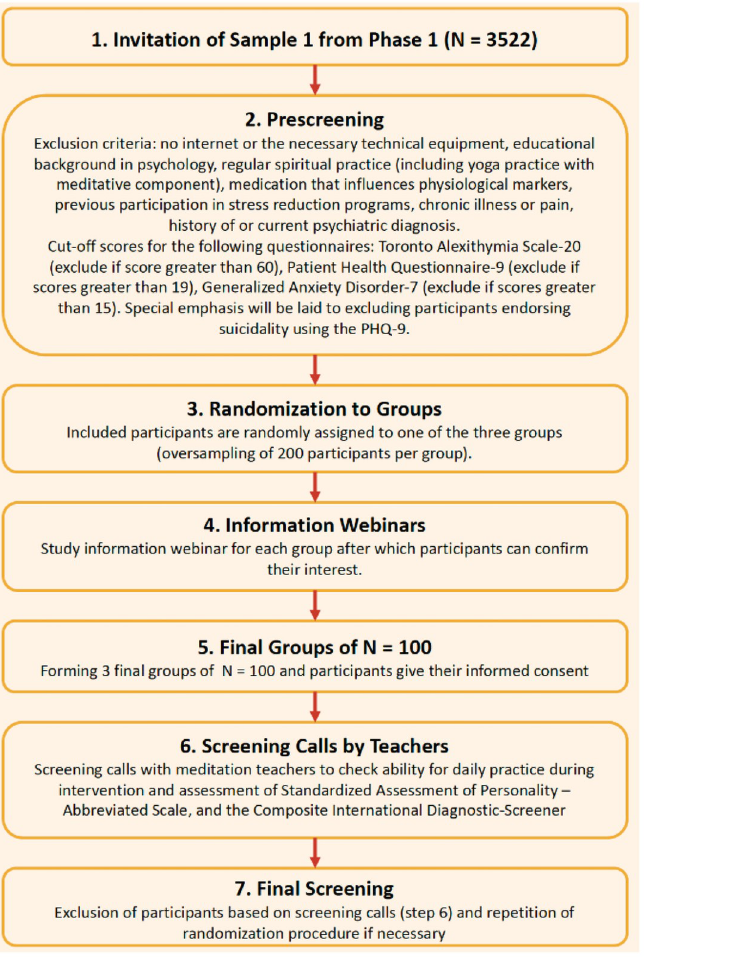
Fig 4. The sampling and randomization